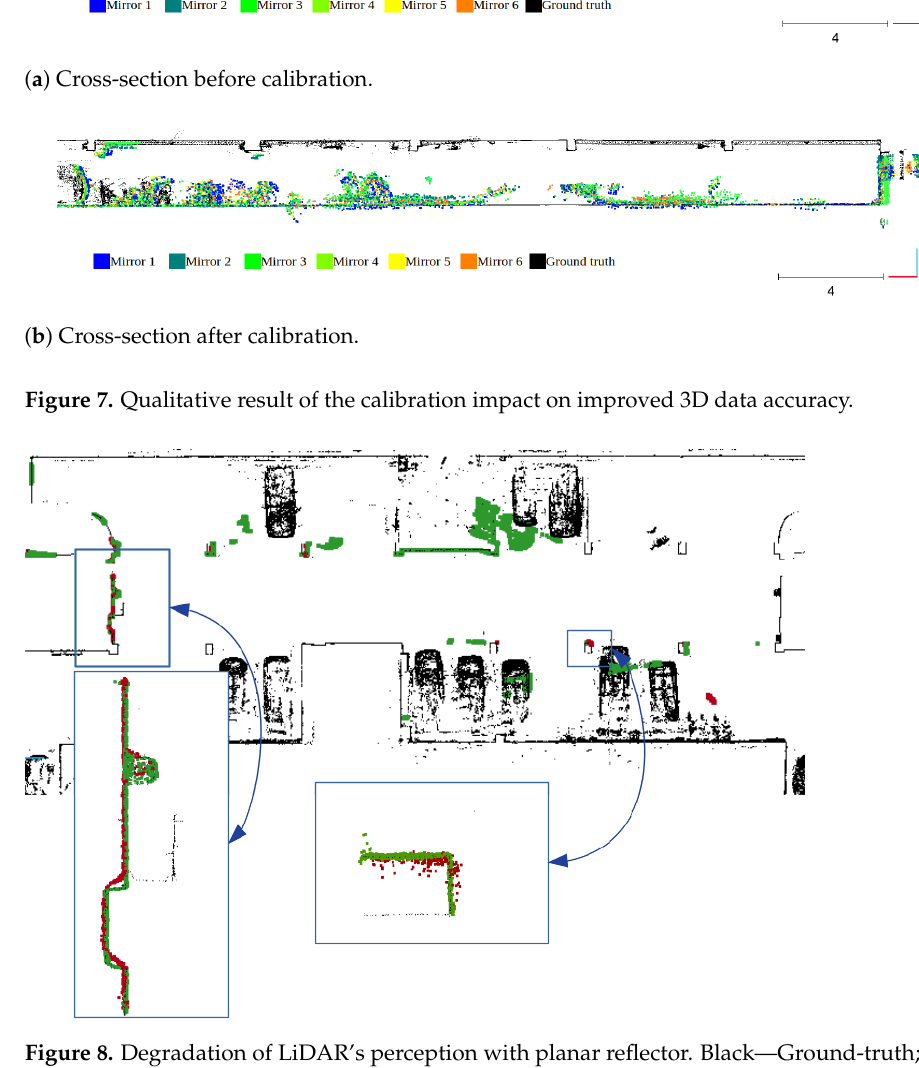
Figure 8. Degradation of LiDAR’s perception with planar reflector. Black—Ground-truth; Green— Livox Mid-40 LiDAR data; Red—Livox Mid-40 LiDAR data with planar reflector. The degradation of sharp corners is evident. The planar target is detected with precision (1 σ ) 1.8 cm (without reflector) and 2.2 cm (with